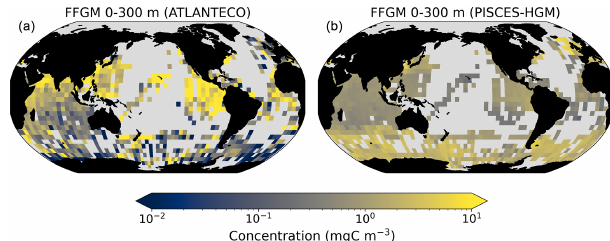
Figure A5. Comparison between AtlantECO-observed and PISCES-HGM-modeled FFGM biomasses. The color bars are in logarithmic scale. (a) Annual average of monthly observations of FFGM concentrations by AtlantECO on 5 ◦ resolution grid. (b) Annual average of monthly modeled FFGM concentrations by PISCES-HGM on 5 ◦ grid, masked for missing monthly observa-